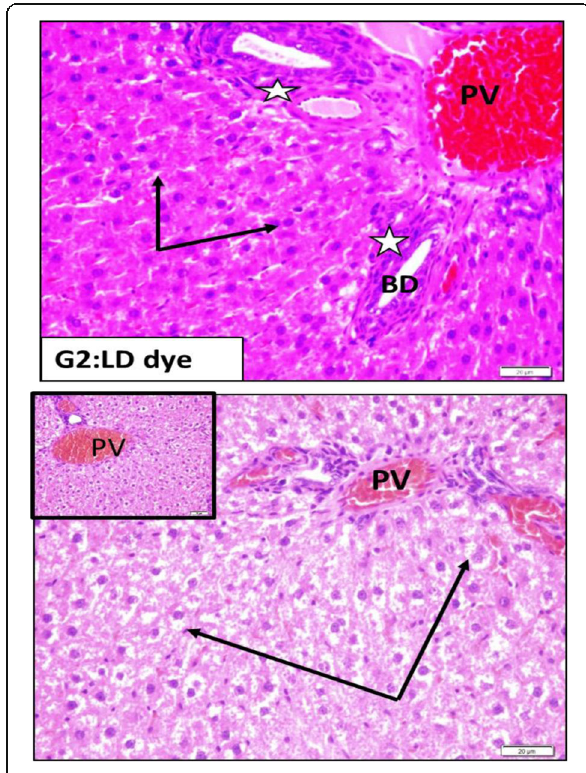
Fig. 3 Sections from the rat liver at portal regions show the following: G2: LD dye (low dose) showing hepatocytes with dark small degenerated nuclei (arrows), congested portal vein (PV), and bile duct (BD) surrounded by inflammatory cells (stars) (H-E, ×